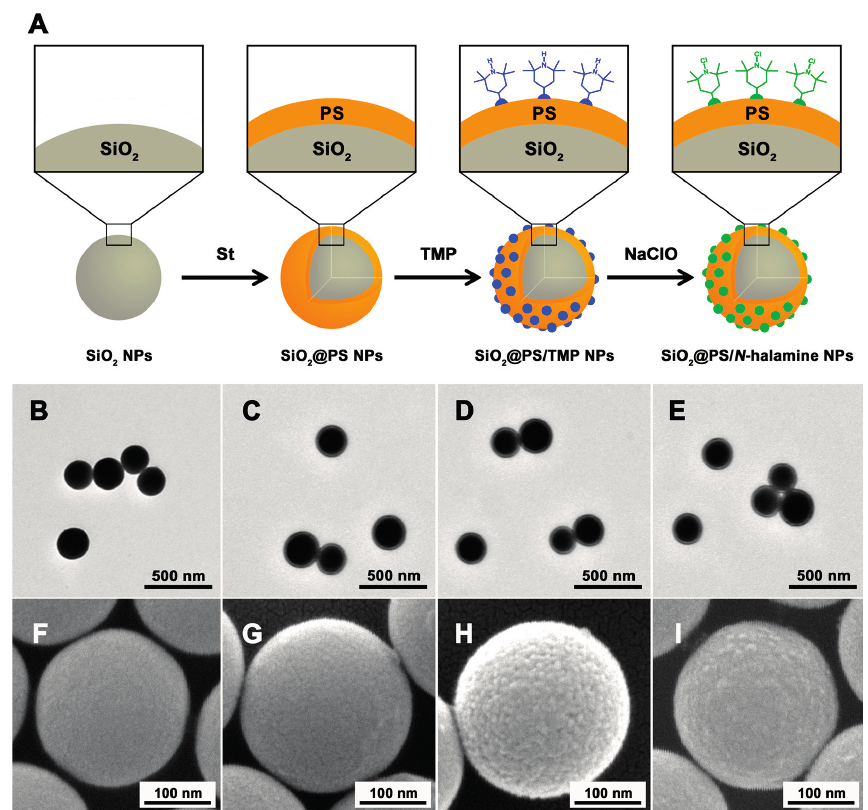
Figure 1. ( A ) Synthesis procedure of SiO 2 @PS/ N -halamine NPs; ( B – E ) TEM and ( F – I ) SEM of SiO 2 NPs (B and F), SiO 2 @PS NPs (C and G), SiO 2 @PS/TMP NPs (D and H), and SiO 2 @PS/ N -halamine NPs (E and